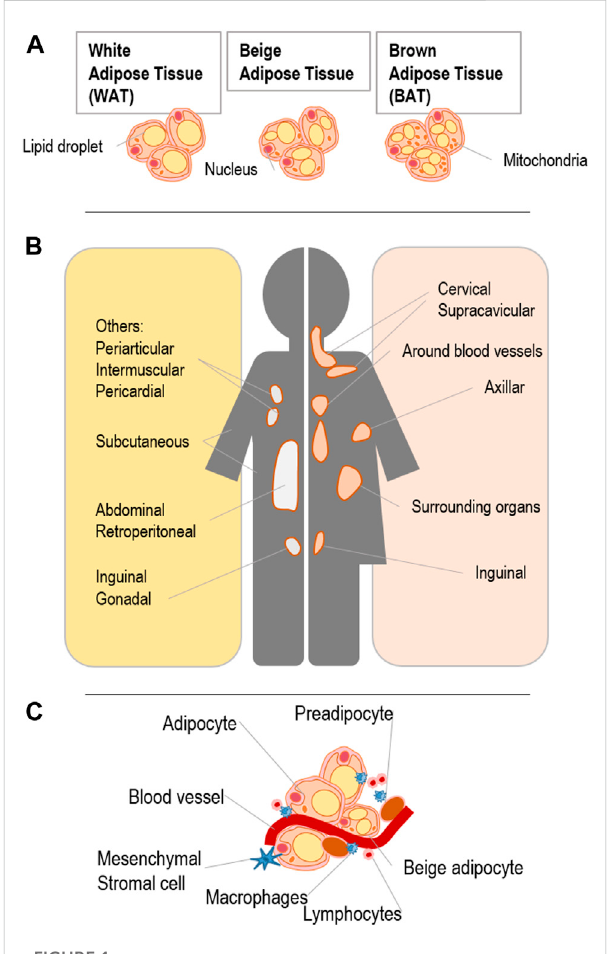
FIGURE 1 Anatomical locations of human WAT/BAT and beige adipose tissue with details on adipose tissue composition adapted from Lenz, et al. (2020): (A) Phenotype of WAT/BAT and beige adipose tissue differs in mitochondrial density and lipid droplet morphology. (B) Speci fi c locations of each type of fat depot (brown or white) can be found throughout the body. Highlighted are the locations of adipose tissue surrounding organs, muscles and blood vessels. (C) Adipose tissue composition including adipocytes, immune cells, endothelial cells and mesenchymal stromal cells, which are all known to facilitate endocrine functions, energy storage and energy